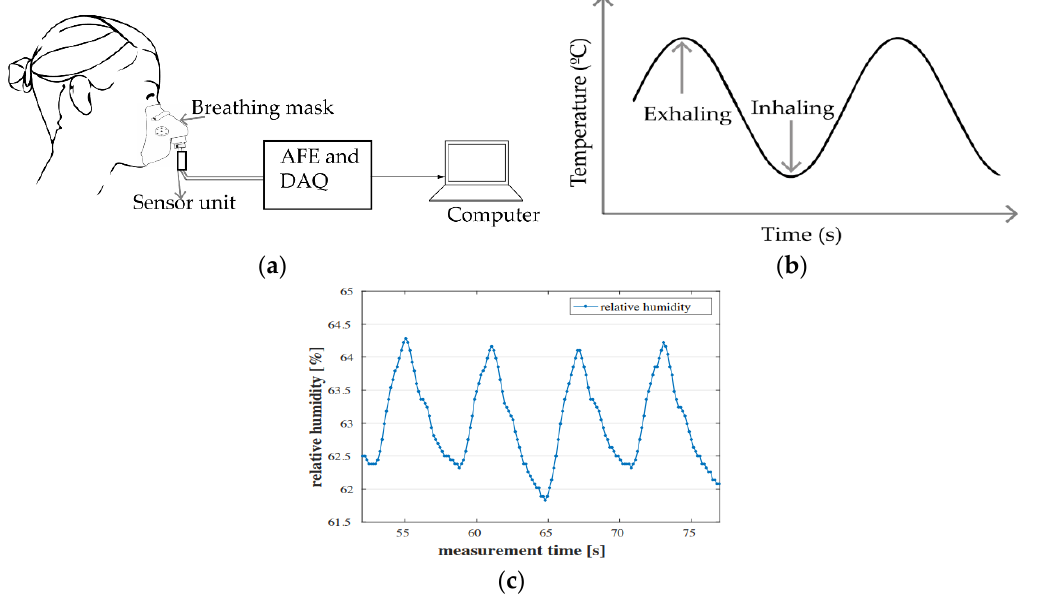
Figure 4. ( a ) General setup for breath airflow-based vital signs monitoring system; ( b ) time response